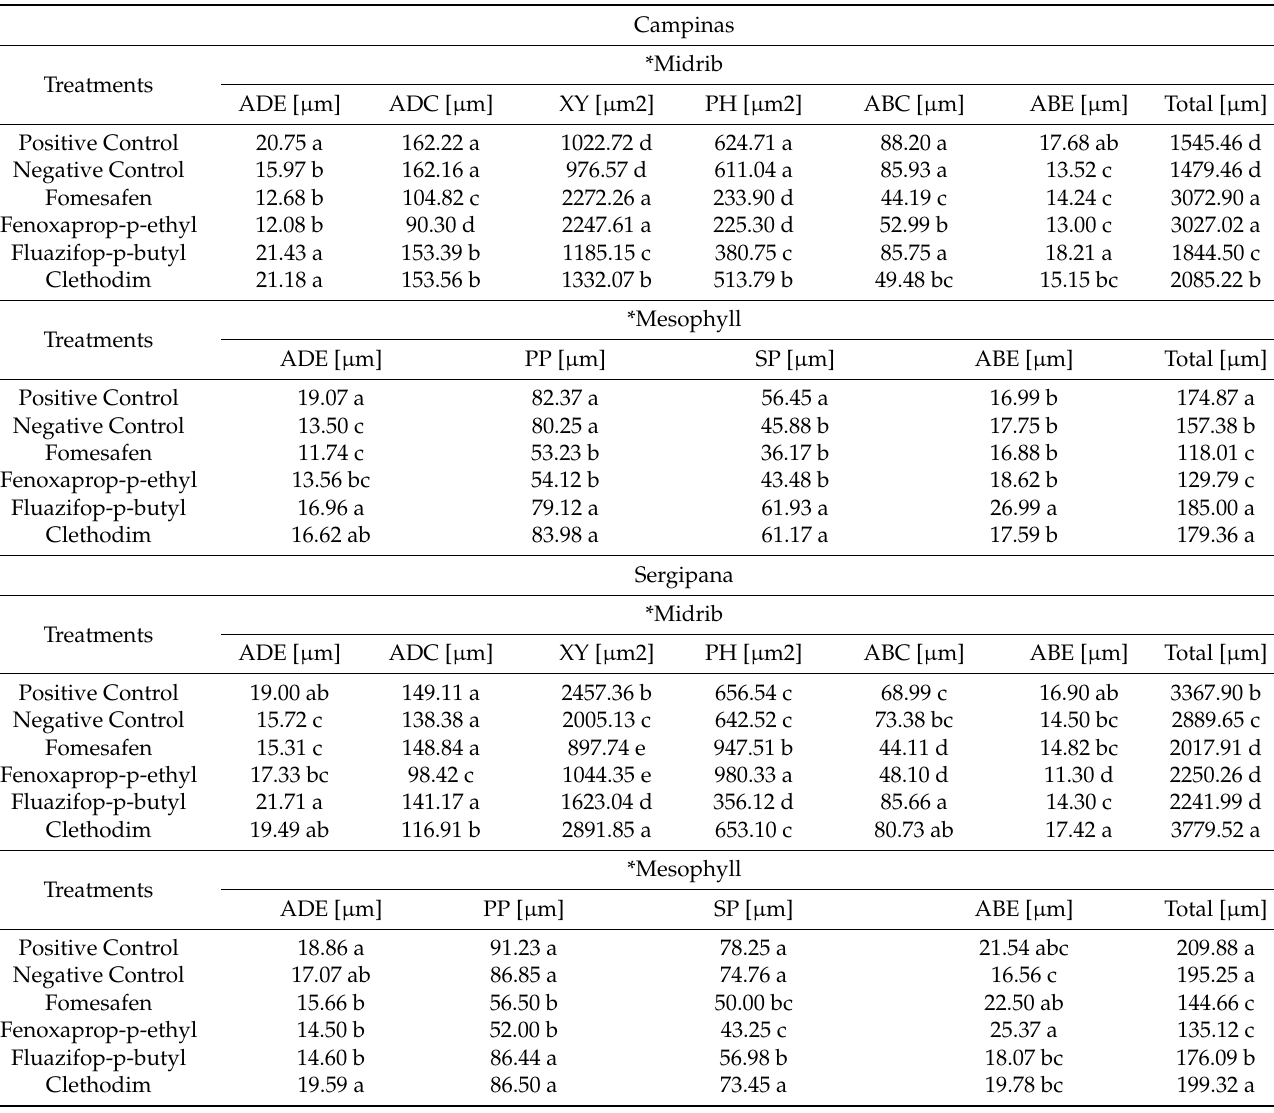
Table 1. Anatomical changes in leaves of Manihot esculenta Crantz of the cultivars Campinas and Sergipana when submitted to different chemical